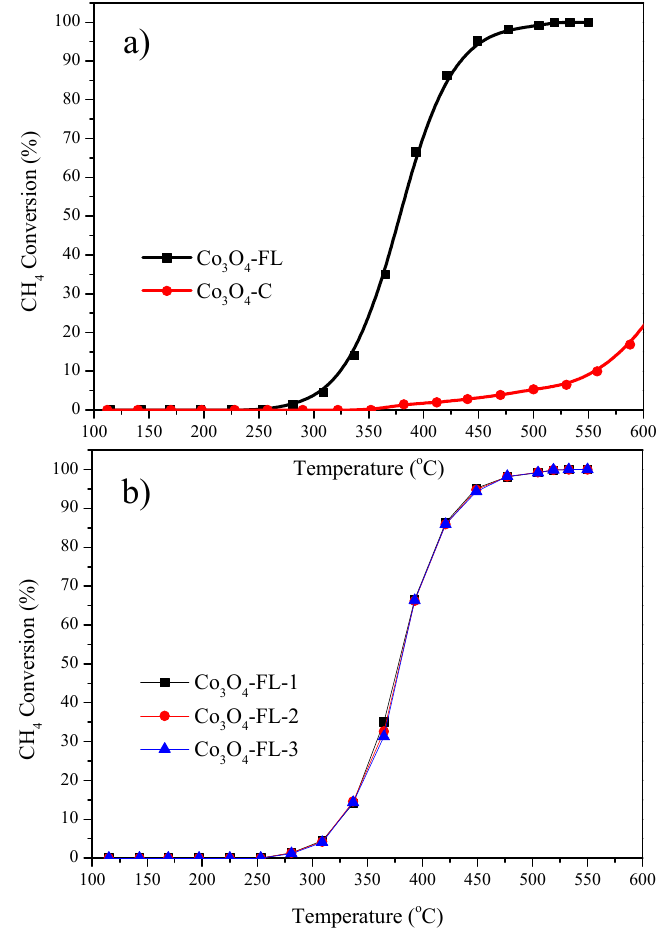
Figure 6. The light-off curves of CH 4 oxidation as a function of reaction temperature over the Co 3 O 4 - FLcatalysts ( a ) and the catalytic stability of Co 3 O 4 -FLcatalysts ( b ) (reactant composition of 2% CH 4 ,